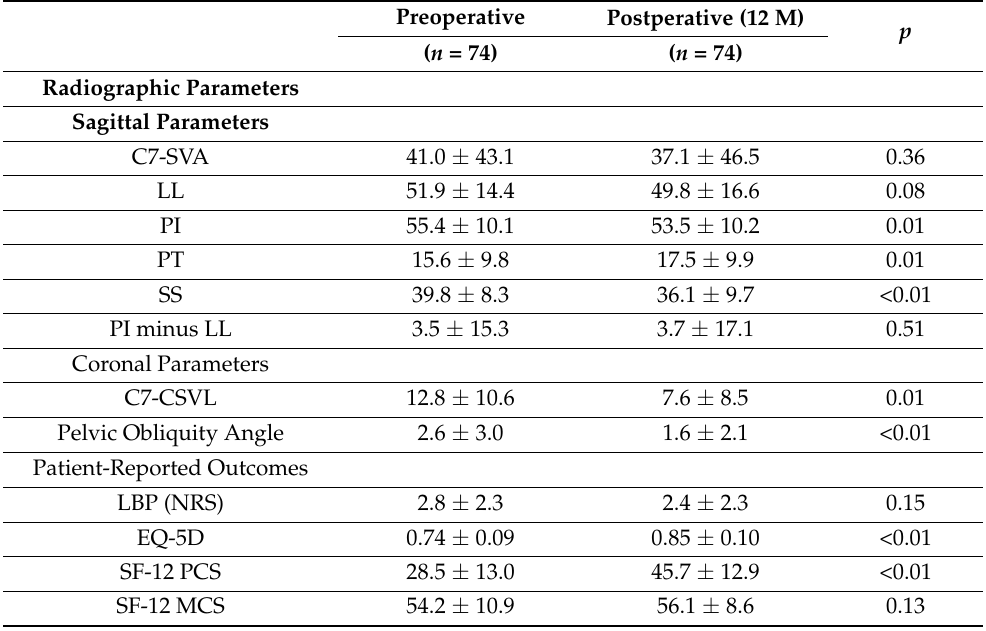
Table 1. Preoperative and postoperative radiographic parameters and patient-reported outcomes.